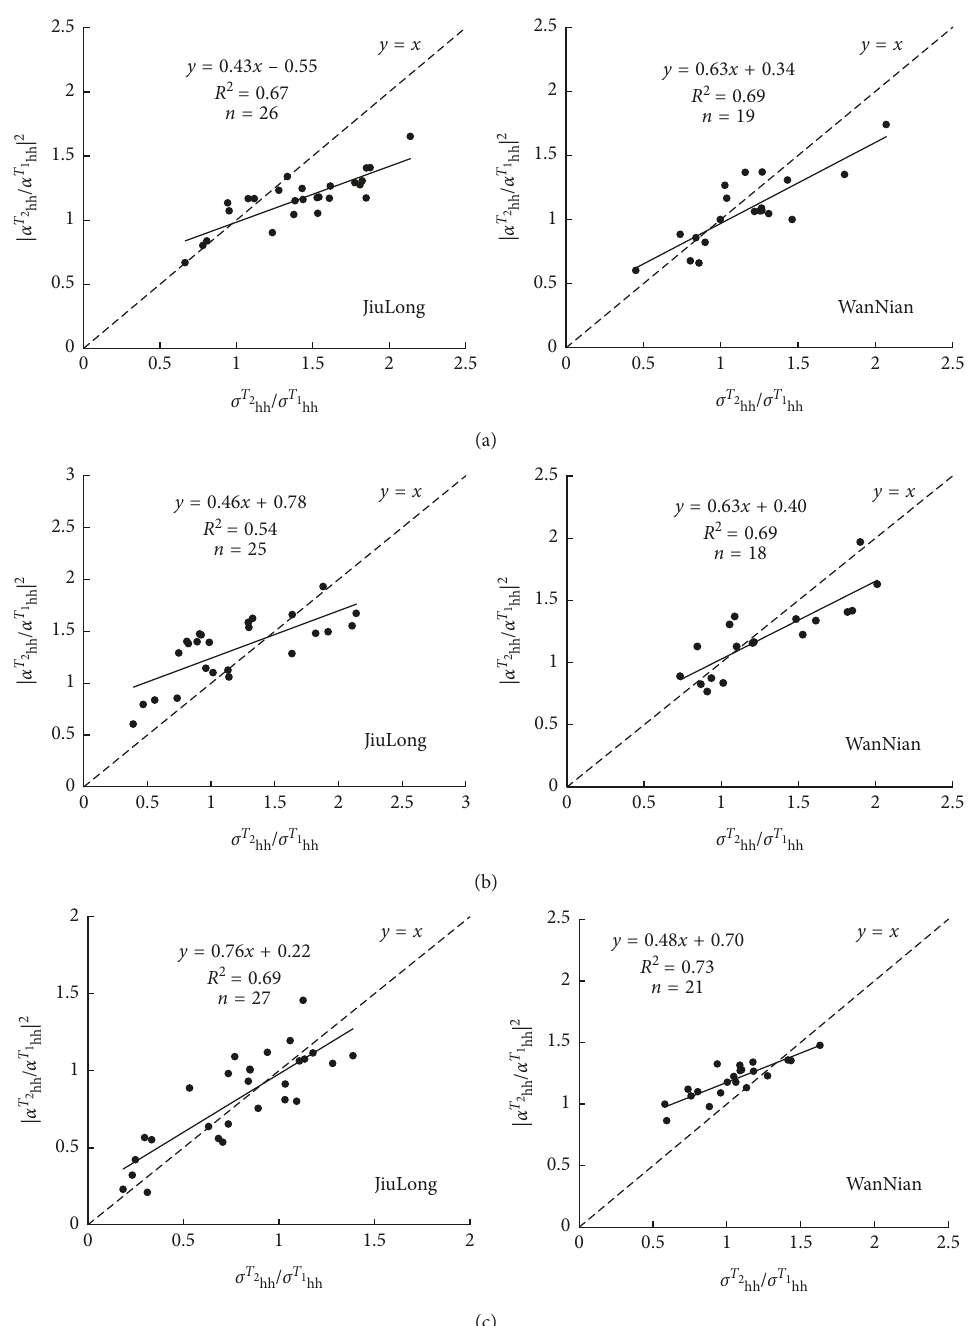
Figure 6: Evaluation for Alpha model using time series Radarsat-2 data and measured soil moisture. (a) Dataset with 24 Dec. 2015 and 17 Jan. 2016. (b) Dataset with 24 Dec. 2015 and 5 Mar. 2016. (c) Dataset with 17 Jan. 2016 and 5 Mar.